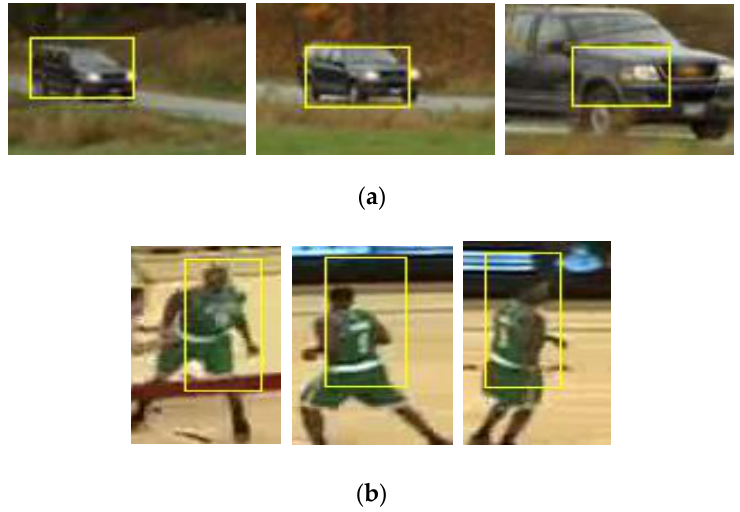
Figure 9. KCF without the scale filter. From the left to the right, ( a ) CarScale sequence: the results are sampled at frame 12, 57 and 176, respectively; ( b ) Basketball sequence: the results are sampled at frame 5, 137 and 204, respectively.